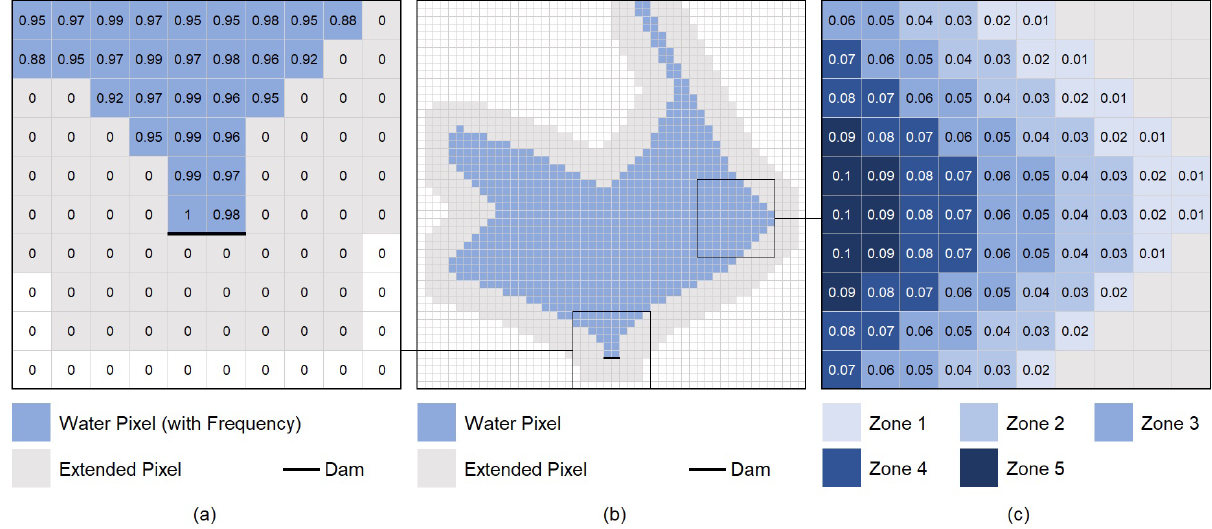
Figure 5. Example of a frequency map (a, b) , expanded mask (a, b) , and zone mask (c) .